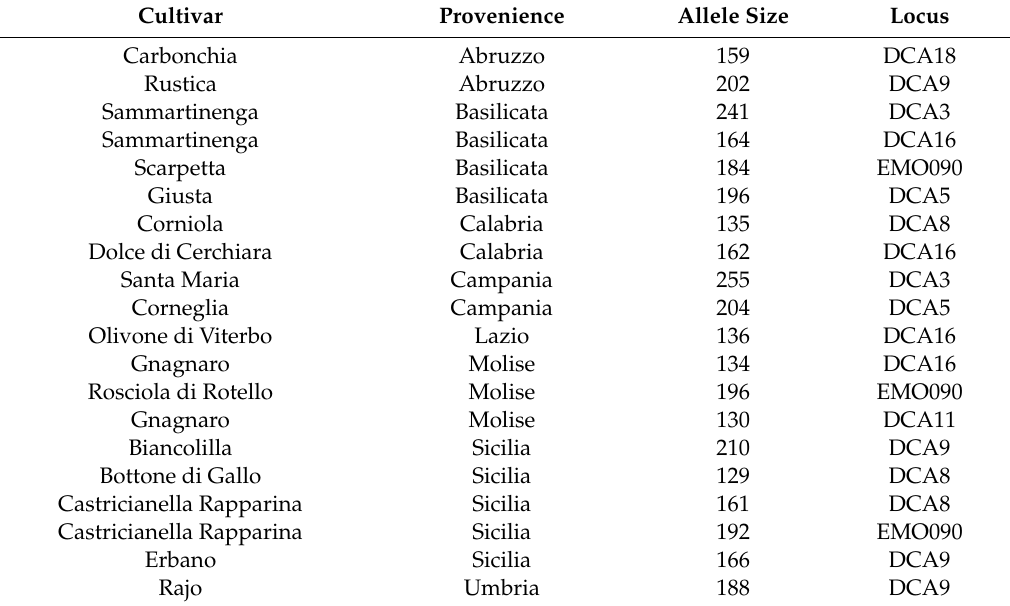
Table 3. Rare alleles detected for each microsatellite locus in the 120 olive